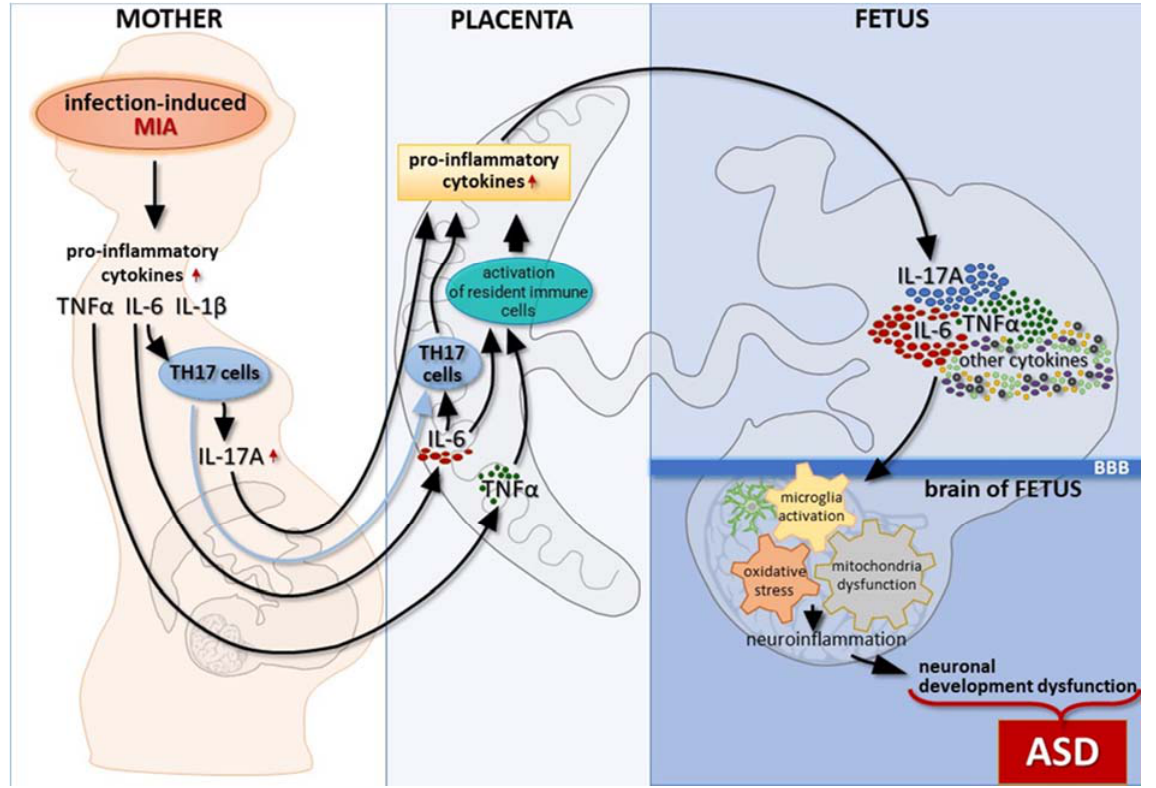
Figure 1. Immunological changes in the placenta and fetal brain in response to systemic inflammation during pregnancy resulting in neuronal development dysfunction in offspring. Infection during pregnancy activates the mother’s immune system, which releases proinflammatory cytokines, such as IL-6, Il-1 β , TNF- α , and others. The elevated level of IL-6 leads to the activation of maternal TH17 cells. As a consequence, IL-17A is released and, together with IL-6 and TNF- α , may reach the placenta, where they additionally activate resident immune cells, resulting in an increased production of proinflammatory cytokines, including IL-6. Moreover, activated maternal TH17 cells also transmigrate through the placenta and enhance cytokine production, which affects placenta function and causes damage. This allows the cytokines to pass through to the developing fetus and enhance the production of fetus-derived cytokines. Then, proinflammatory cytokines cross the BBB and initiate a neuroinflammation cascade. This leads to the abnormal development of neurons, as well as alterations in synaptic transmission, which may further lead to the development of ASD in subsequent stages of growth.